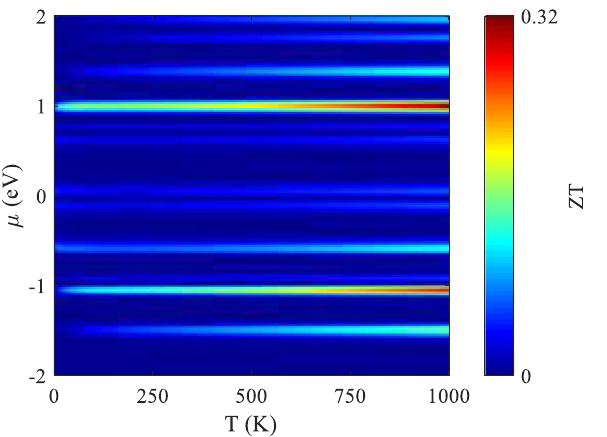
Figure 8. The ZT variation as a function of temperature and chemical potential for SV-18–24 in a system with L D 59.03 ≈